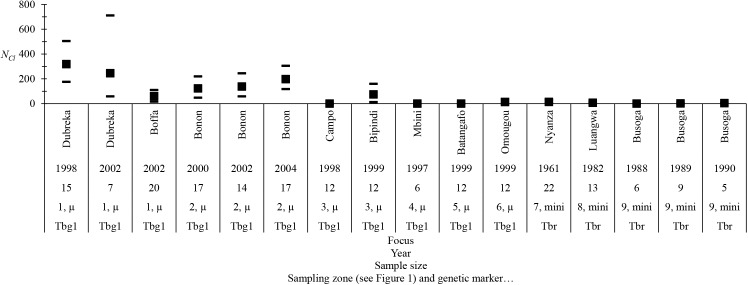
Estimates of clonal population sizes, N
Cl = -(1+F
IS)/(4uF
IS) for an isolated clonal population, of Trypanosoma brucei gambiense type 1 (Tbg1) and T. b. rhodesiense (Tbr) infecting humans with a mutation rate u = 10−3 for microsatellite markers (μ) and u = 0.03 for minisatellite markers (mini).The name of the focus, the year of sampling, and the sample sizes are shown on the abscissa. Labels of sampling zones are the same as in Fig 1. For higher mutation rates (e.g., u = 0.0001 or 0.00001 for microsatellites), N
Cl values must be multiplied by 10 and 100, respectively.